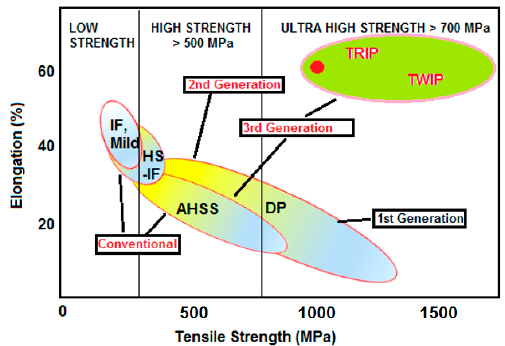
Figure 1. An overview of important advanced high strength steels (AHSSs).